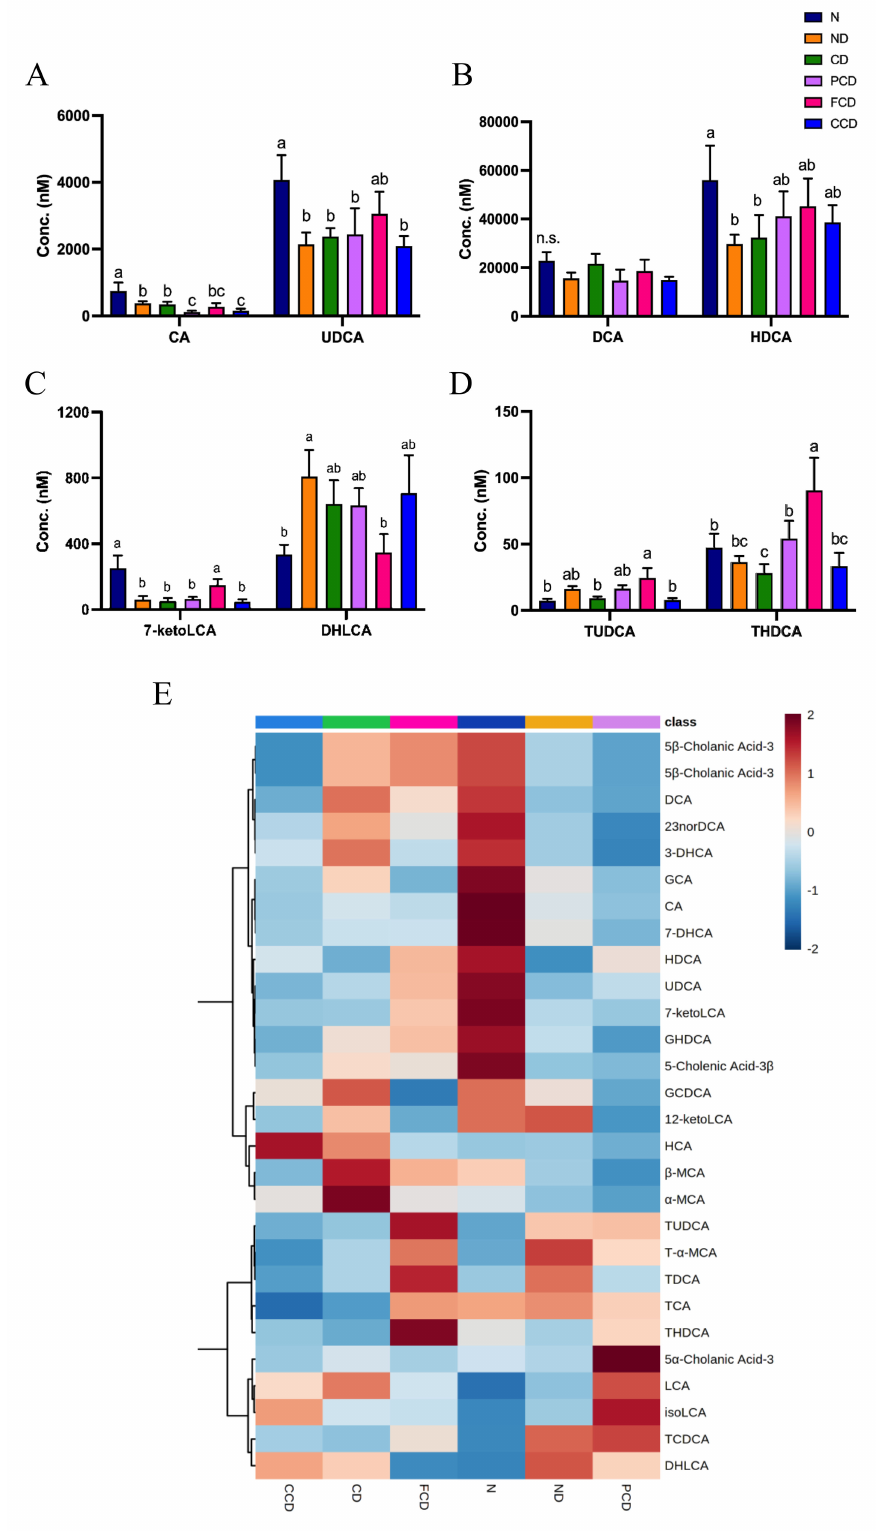
Figure 4. Bile acid profiles of rodent faecal samples. ( A ) Dominant primary bile acids in rodent faeces; ( B ) Dominant secondary bile acids in rodent faeces; ( C ) Levels of secondary bile acids 7 − ketoLCA and DHLCA; ( D ) Levels of taurine-conjugated bile acids TUDCA and THDCA; ( E ) Heatmap of levels of 28 bile acids in each group. Data are expressed as means ± SDs ( n = 6). Values with different superscript letters differ significantly ( p <